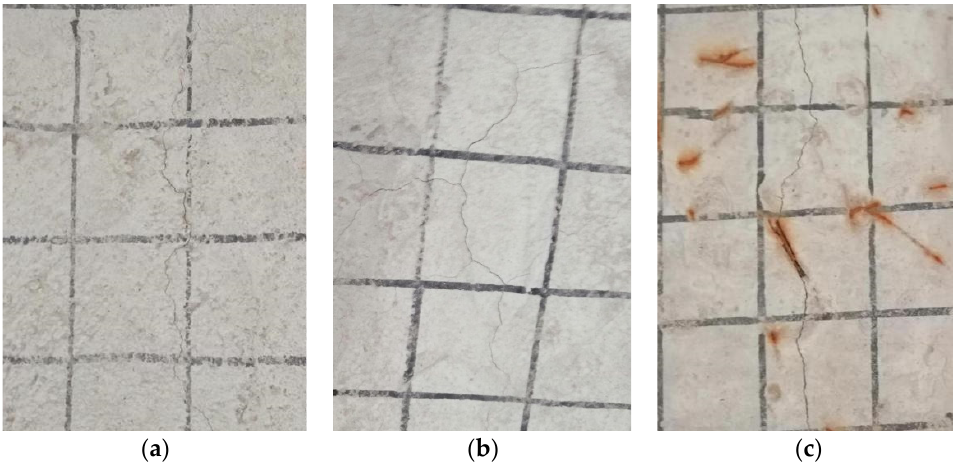
Figure 4. Signs of Lattice Crack in Bridge Deck under Fatigue Loading ( a ) PL3, ( b ) PL4, and ( c ) PL5.